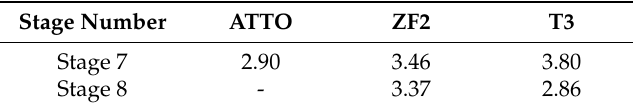
Table 4. Effective number of clusters for the available sampling site and stage data. The lower the value, the fewer clusters needed to characterize a majority of the